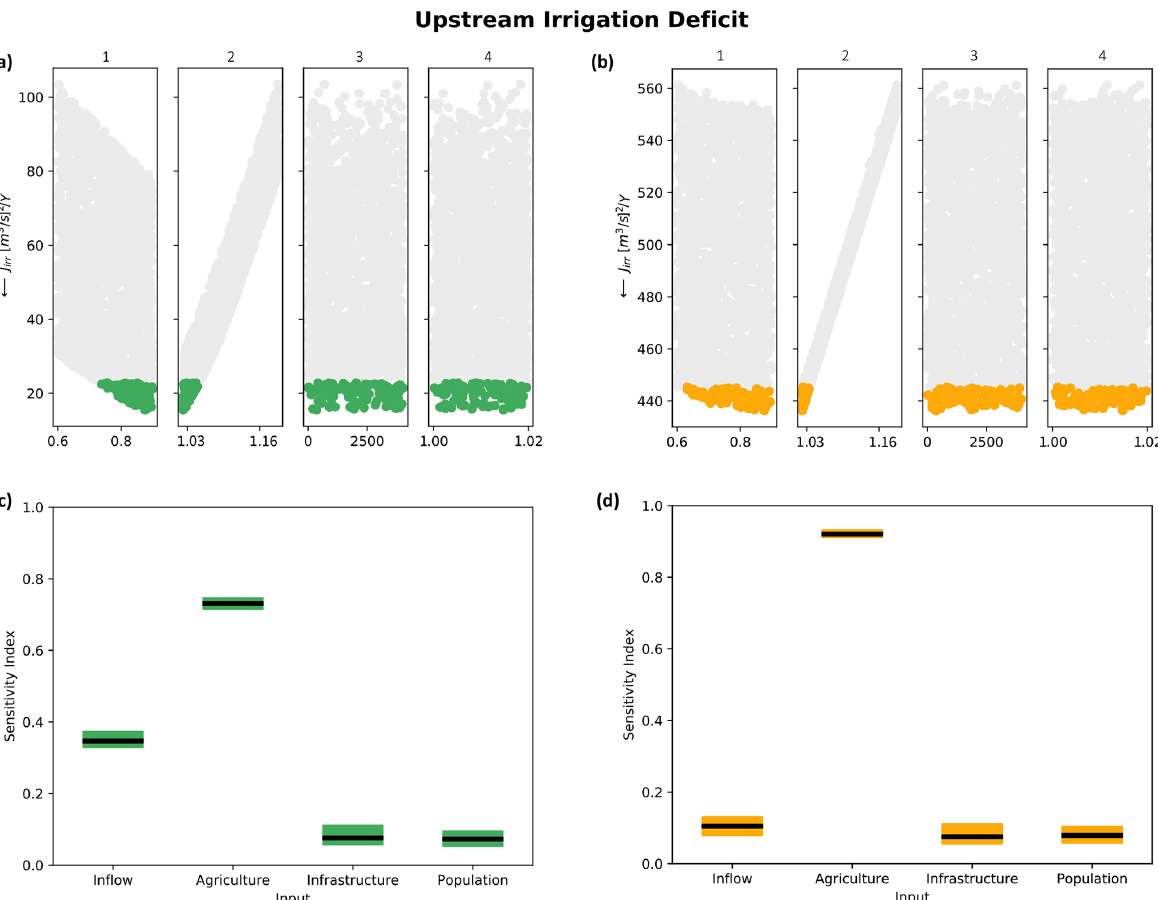
Figure 9. Behavioral perturbations (a, b) and sensitivity index (c, d) for the robust upstream irrigation (green) and robust hydropower (yellow)